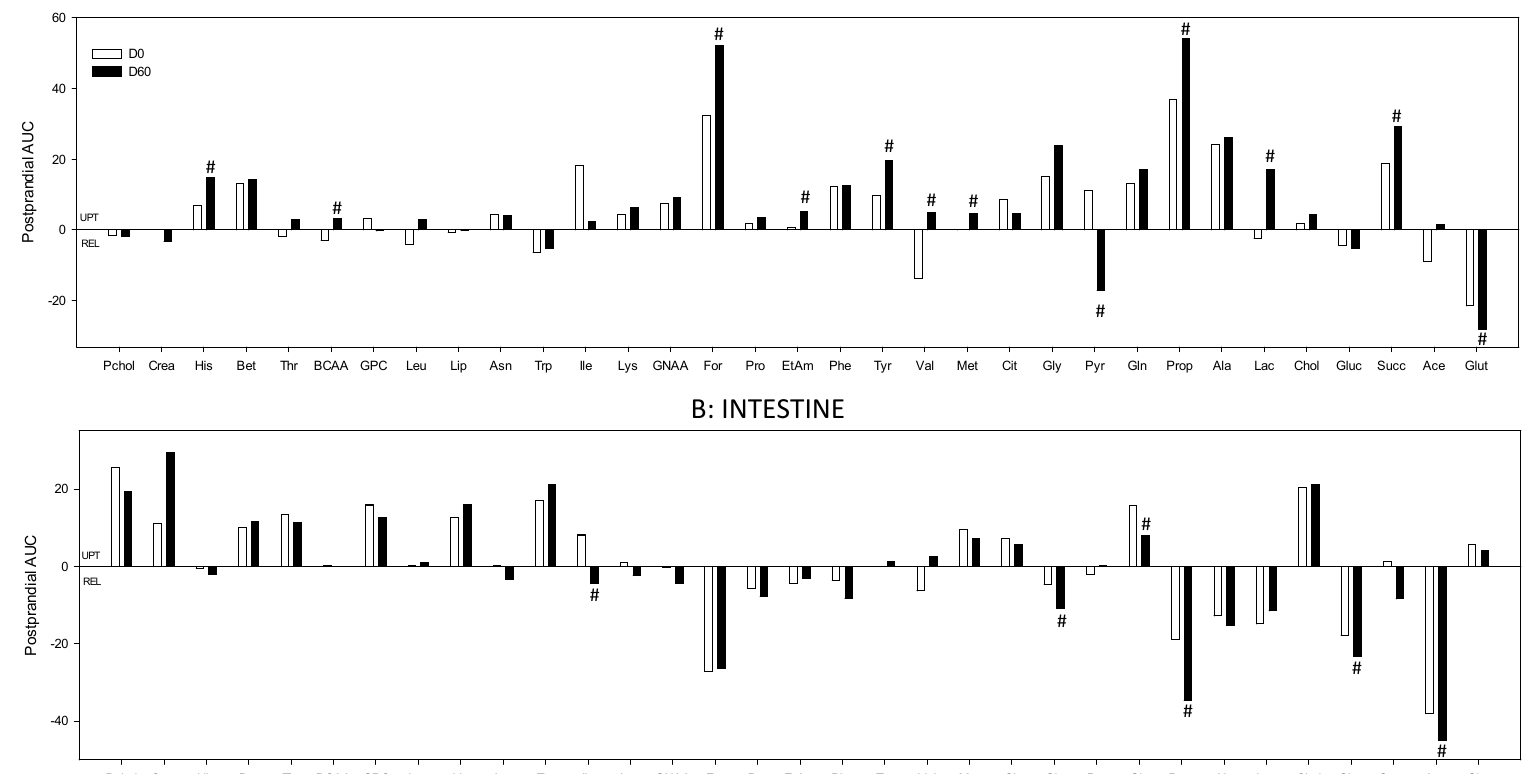
Figure 3. Arteriovenous global exchanges during the postprandial period (AUC) across the liver ( A ) and the intestine ( B ). Data is presented in % of induction (mean): positive values = taken up by the organ; negative values = released by the organ. Data were analyzed using a paired t -student test. #, significantly different from D0, p < 0.05. Detailed data are presented in the supplemental Tables S1 and S2 (Supplementary Materials). Pchol, phosphocholine; Crea, creatine; His, histidine; Bet, betaine; Thr, threonine; BCAA, branched-chain amino acids; GPC, glycerophosphocholine; Leu, leucine; Lip, lipids; Asn, asparagine; Trp, tryptophan; Ile, isoleucine; Lys, lysine; GNAA, gluconeogenic amino acids; For, formic acid; Pro, proline; EtAm, ethanolamine; Phe, phenylalanine; Tyr, tyrosine; Val, valine; Met, methionine; Cit, citrate; Gly, glycine; Pry, pyruvate; Gln, glutamine; Prop, propionate; Ala, alanine; Lac, lactate; Chol, choline; Gluc, glucose; Succ, succinate; Ace, acetate; Glut, glutamate.